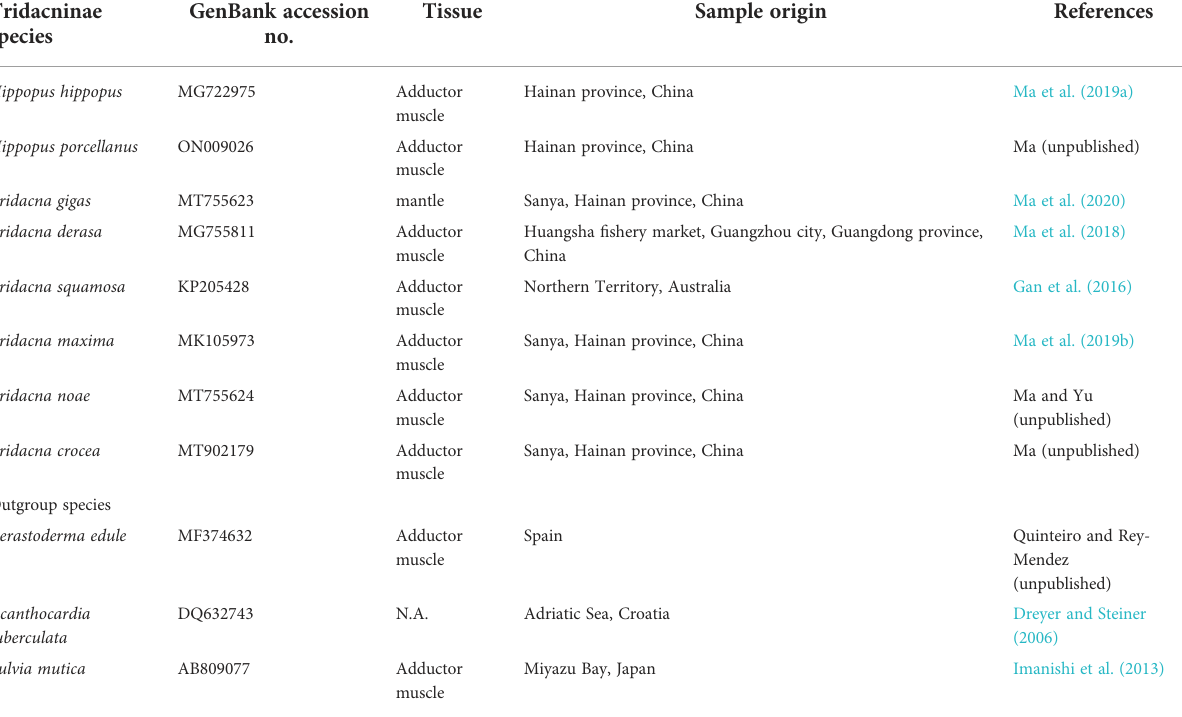
TABLE 1 Overview of the Tridacninae species, including three outgroup species, examined in this